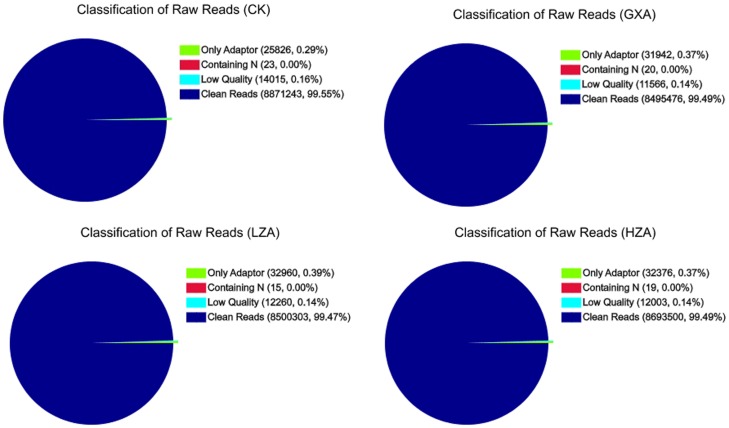
Evaluation of sequence quality for the four resistance levels of P. xylostella.CK: SS Strain; LZA: LLR strain; GXA: MR strain; HZA: HR strain.